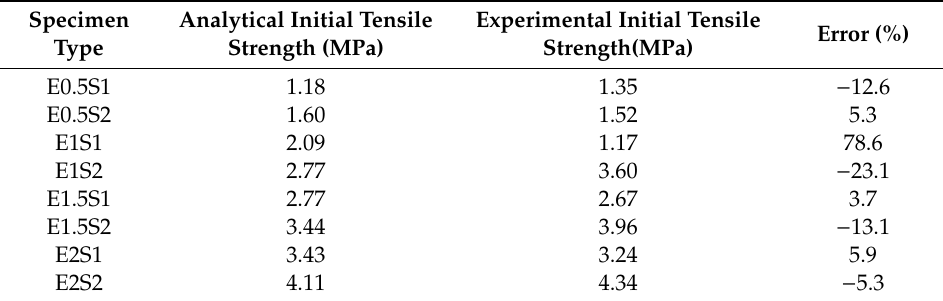
Table 9. Comparison of analytical and experimental initial tensile strengths of steel grid-PE fiber reinforced